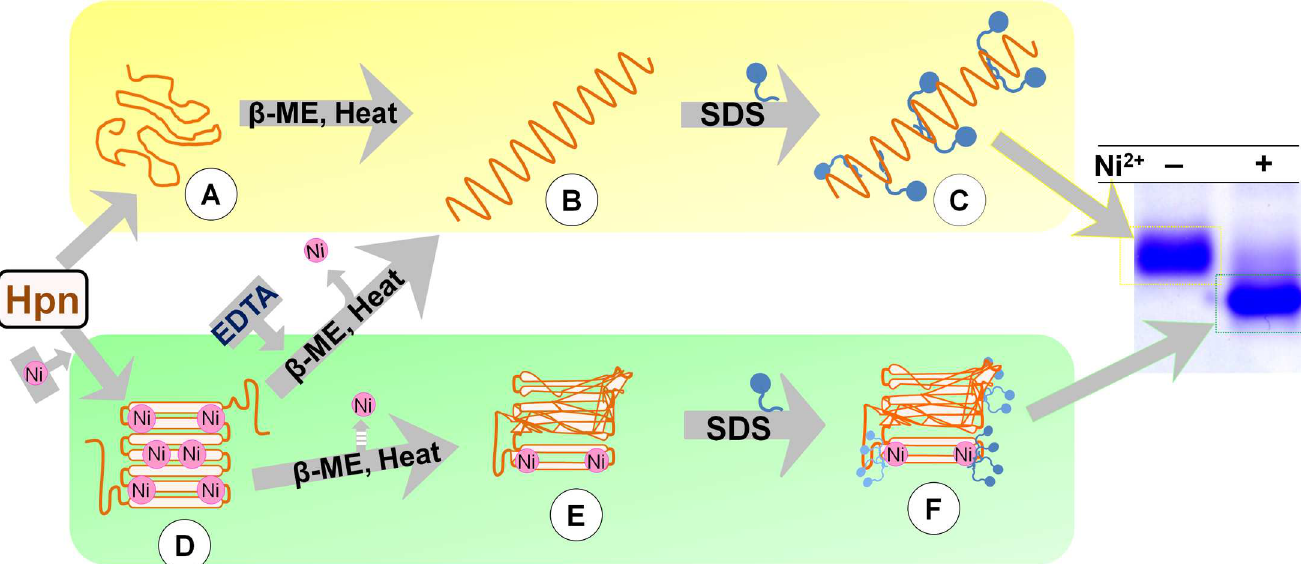
Fig 7. Probable interrelationship between differential electrophoretic mobility of Hpn and Ni 2+ binding. Hpn may not have a definite form in the absenceof Ni 2+ (A). After denaturation(B), smaller amounts of SDS binding/stacking behavior/larger hydrodynamic radius as well as a combination of some or all of these conditions (C) might have resulted in slower migrationon SDS-PAGE (scheme highlightedwith yellow background). Ni 2+ -treated Hpn forms a more compact structure (D). Pictorial structure of metalatedHpn is drawn to explainthe model. MALDI spectra showed a partial Ni 2+ boundform (E) in denatured SDS-PAGE. Altered bindingof SDS (F) caused by replacement of protein-protein to protein-SDScontacts (inhibitingstacking behavior) and/or degreeof compactness (or reducedhydrodynamic radius) may be key factors responsiblefor “metal gel-shift” (scheme highlightedwith green background). β -ME, β -mercaptoethanol; EDTA, ethylenediaminetetraacetic